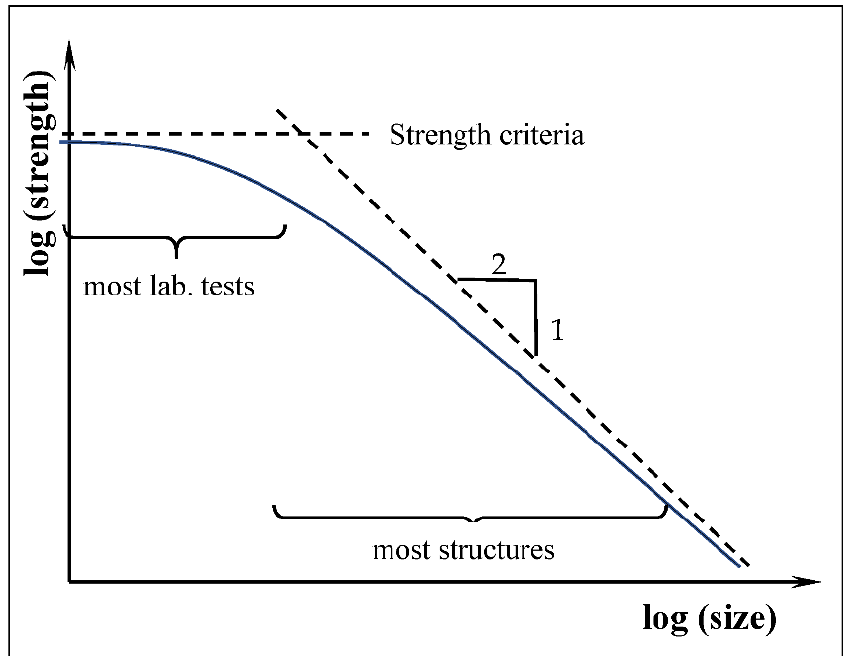
Figure 1. Shear strength with increasing size. Adapted from [30].